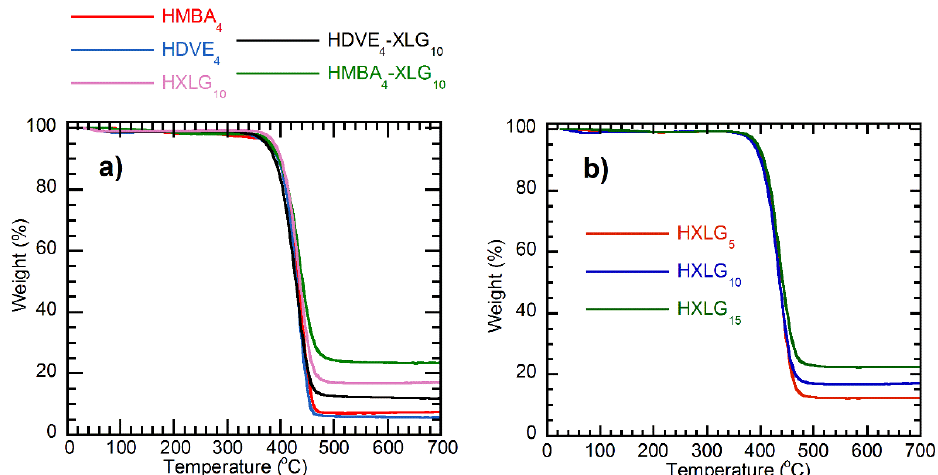
Figure 7. TGA plots for the hydrogels obtained: ( a ) the effect of the crosslinker type; ( b ) the effect of the XLG concentration.